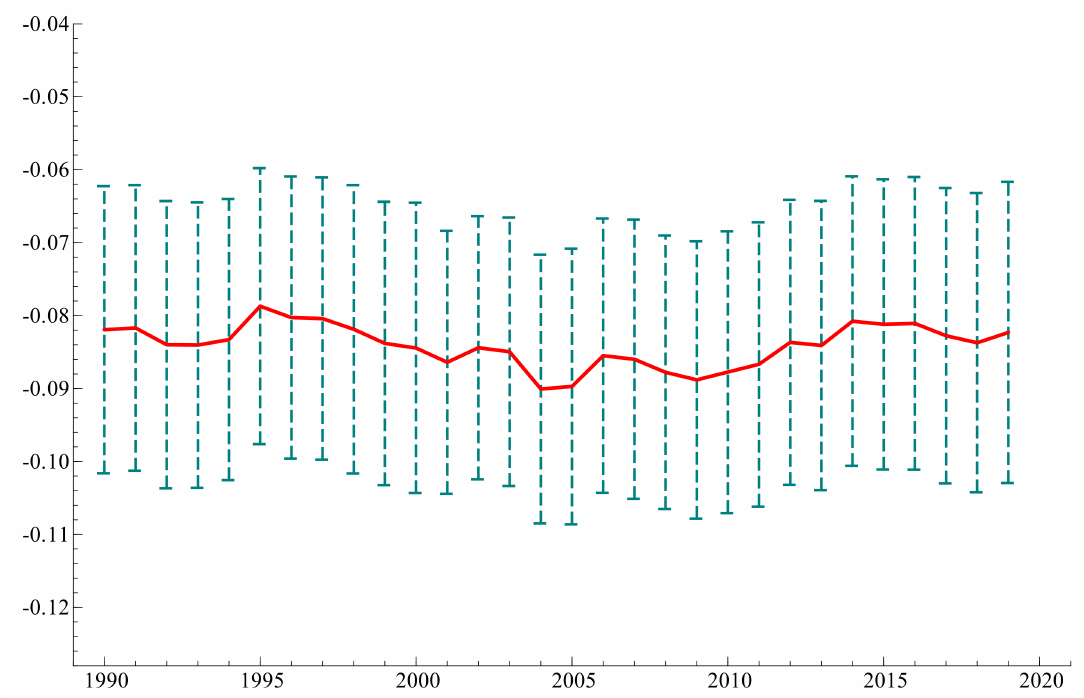
Figure 2. Time-varying parameter of the share of gas consumption variable, with 99% confidence